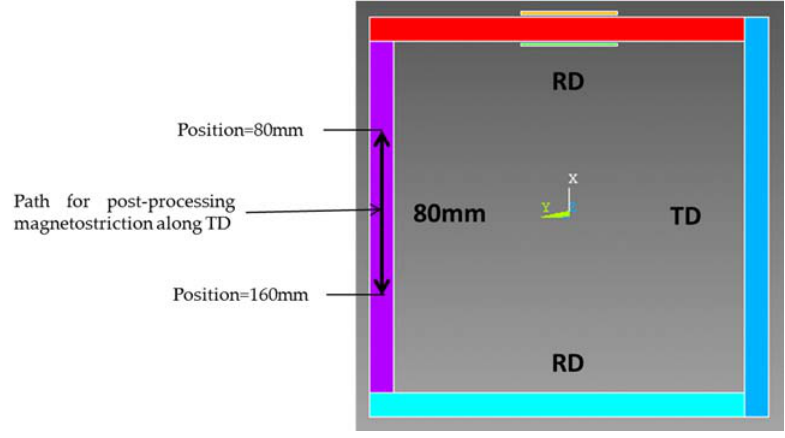
Figure 9. Computing magnetostriction along TD.